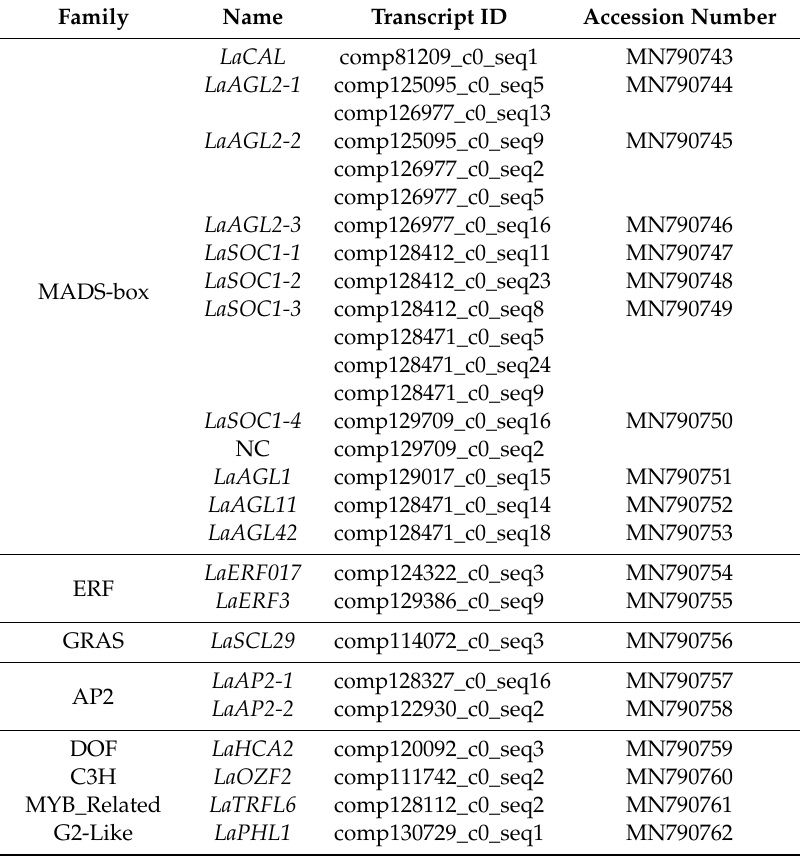
Table 2. Analysis of 27 transcripts expressed di ff erentially between juvenile vegetative (1-